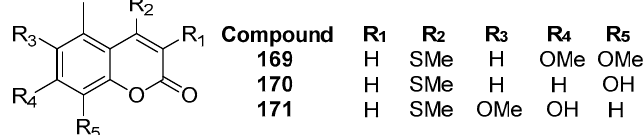
Figure 57. Chemical structure of compounds 169 , 170 and 171 .